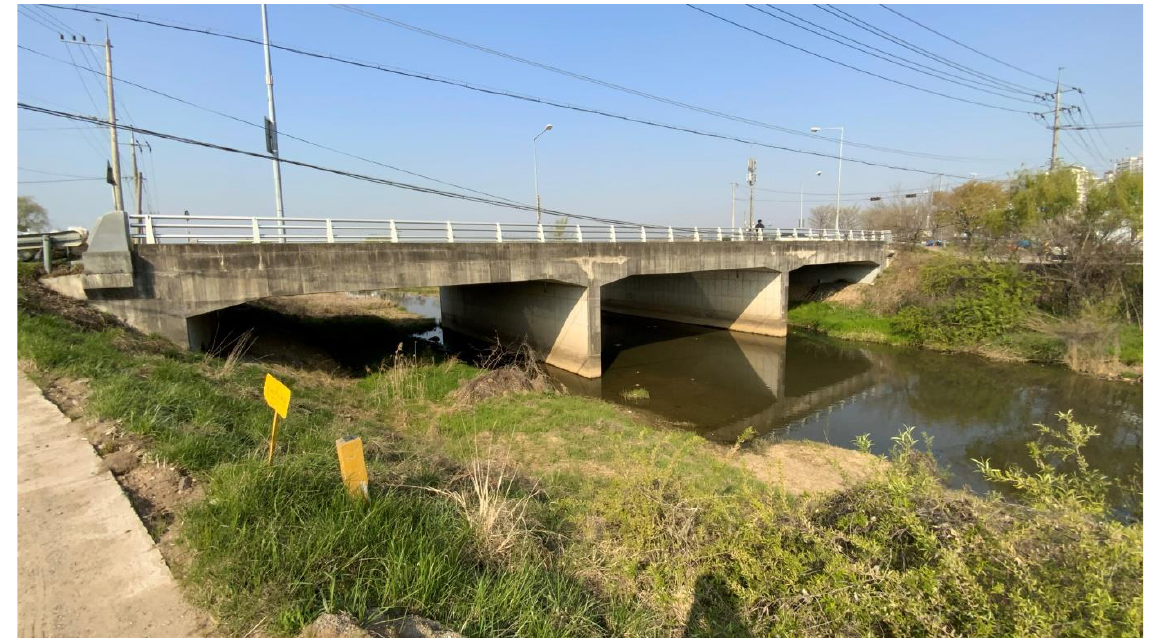
Figure 2. Gajwa Bridge (RC rahmen bridge).